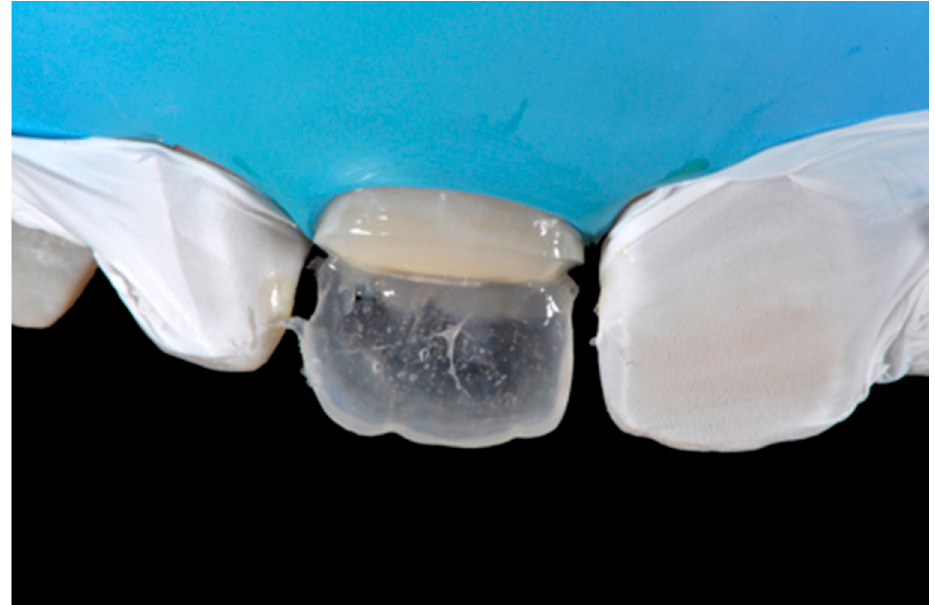
Figure 5. Palatal wall is molded and silicone index removed. Reprinted from Restauri diretti nei settori anteriori, G. Paolone, S. Scolavino, © 2021, with permission from Quintessence Publishing Italy.